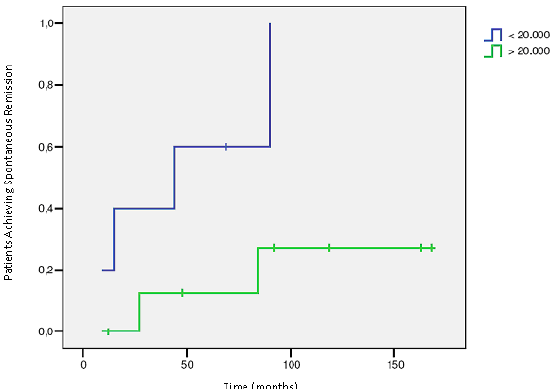
Figure 1. Kaplan-Meier analysis for platelet count at diagnosis variable. The analysis shows a higher probability of complete remission for patients with a platelet count at diagnosis lower than 20,000/μl (p <